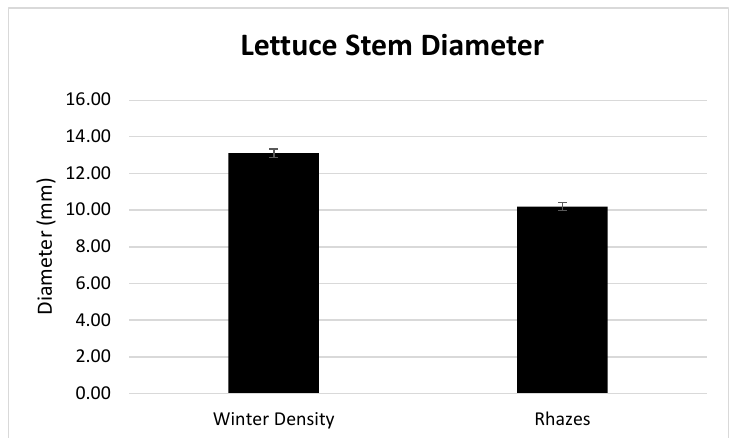
Figure 2. The effect of growing season on lettuce stem diameter. The standard error of the mean was: stem diameter ± 0.28.